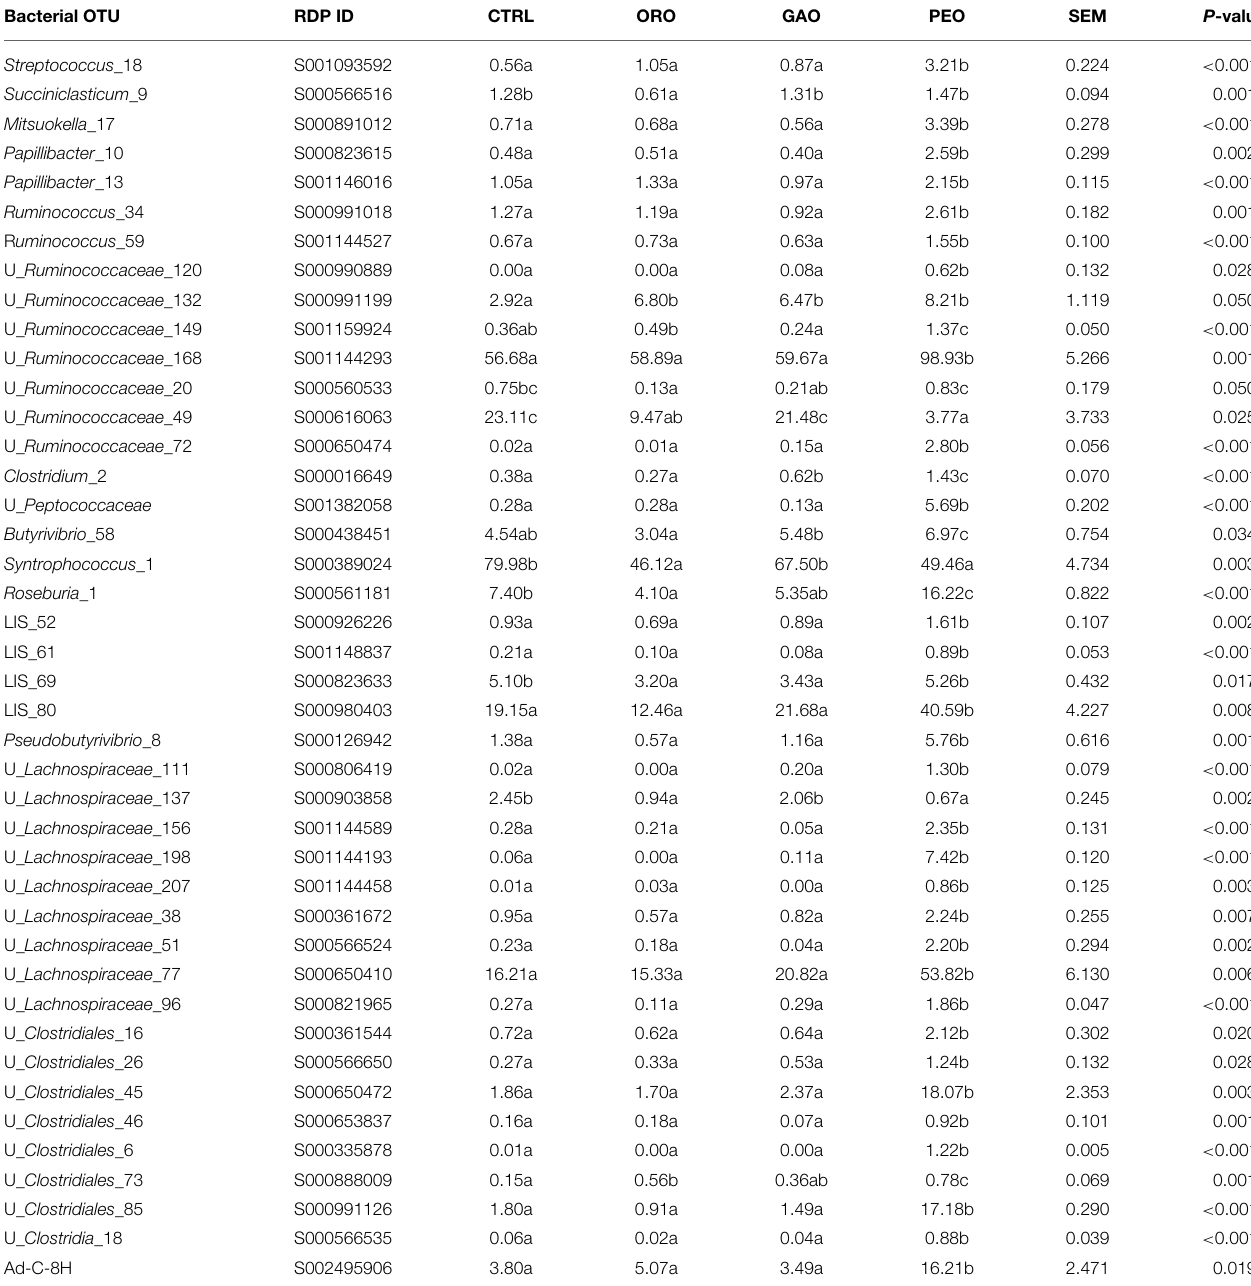
TABLE 2 | Effects of essential oils on populations of the ruminal bacteria in the phylum Firmicutes [only the OTUs with significant ( P ≤ 0 .05) changes in relative abundance are shown]. Bacterial